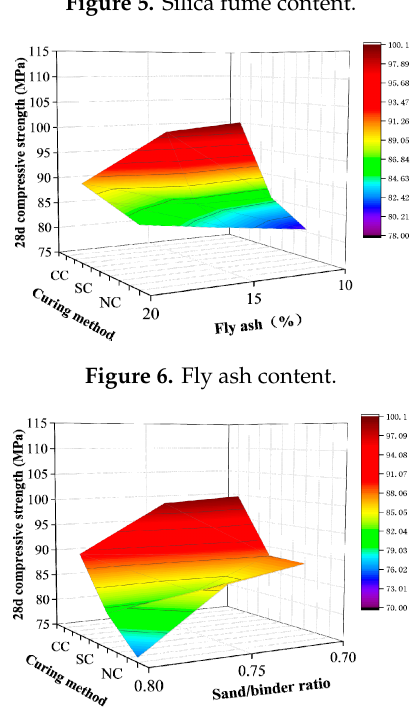
Figure 7. Sand / binder Figure 7. Sand/binder ratio. Figure 7. Sand/binder ratio. Figure 7. Sand/binder ratio. Figure 7. Sand/binder ratio.